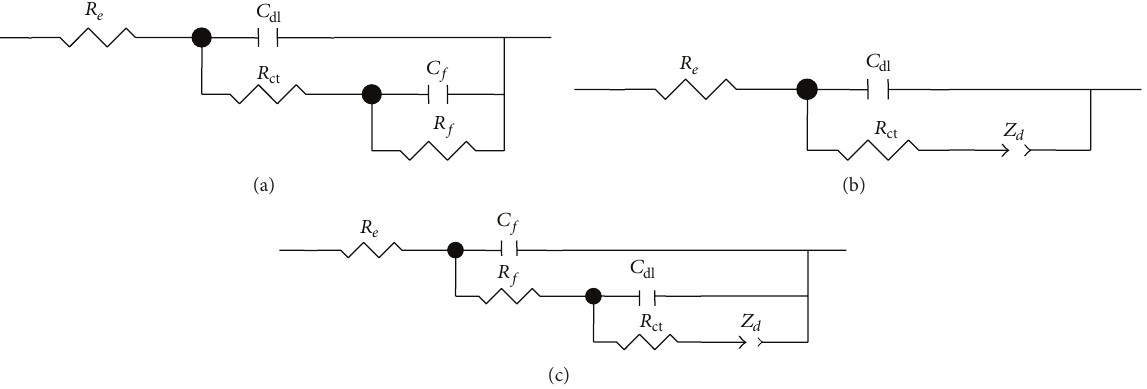
Figure 9: Equivalent circuits for the corrosion of the three stainless steels in molten carbonate at 650 ∘ C.